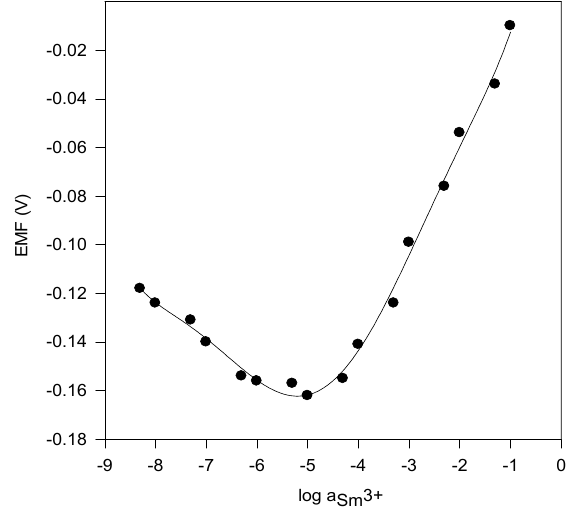
Figure 1. Calibration curve for Sm (III) selective electrode based on